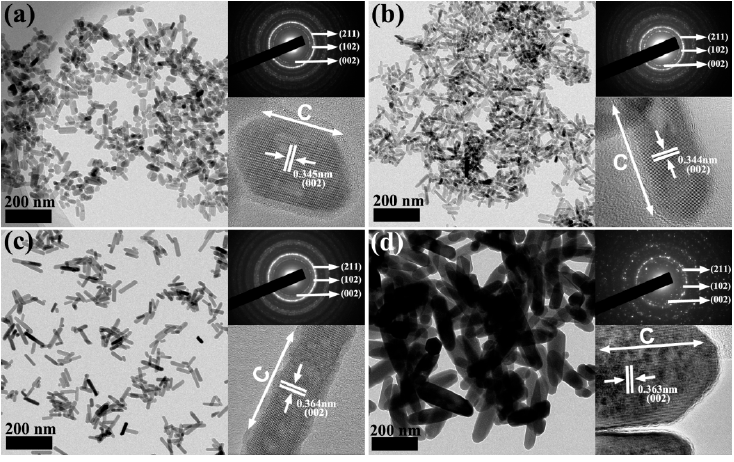
Figure 4. Transmission electron microscopy (TEM) and selected-area electron diffraction (SAED) patterns of the synthesized samples: (a) HA-1, (b) HA-2, (c) SrHA-1, and (d) SrHA-2. For the sake of comparison, the distribution of length, width, and aspect ratio of the samples were manually measured, as shown in Figure 5. It was evident that the length of SrHA-2 (approximately 100–300 nm) was higher than that of the other three (lower than 100 nm). Meanwhile, SrHA-2 had the largest width (40–80 nm); HA-1 took the second place (15–40 nm), and HA-2 and SrHA-1 were the smallest (10–20 nm). In addition, HA-2, SrHA-1, and SrHA-2 had a similar aspect ratio (1.5–6.0), while it ranged from 1.0 to 3.0 for HA-1. These results indicated that both the length and width of SrHA-2 are significantly larger than those of the other three ( p < 0.01). HA-2, SrHA-1,